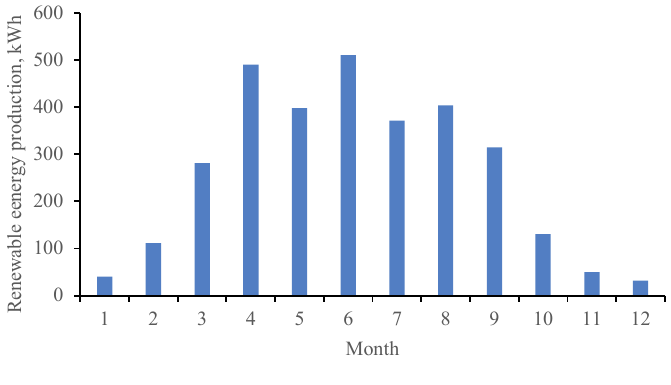
Fig. 3. Renewable energy production by